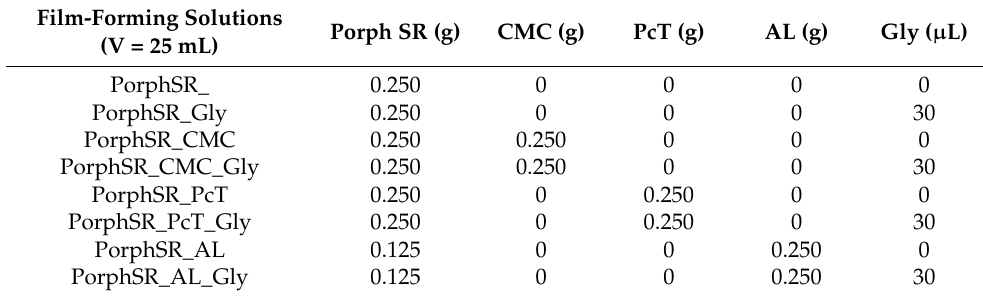
Table 1. Composition of film-forming solutions by components, semi-refined porphyran extracted by the Sohxlet method, sodium carboxymethylcellulose (CMC), pectin (PcT), sodium alginate (AL) and glycerol